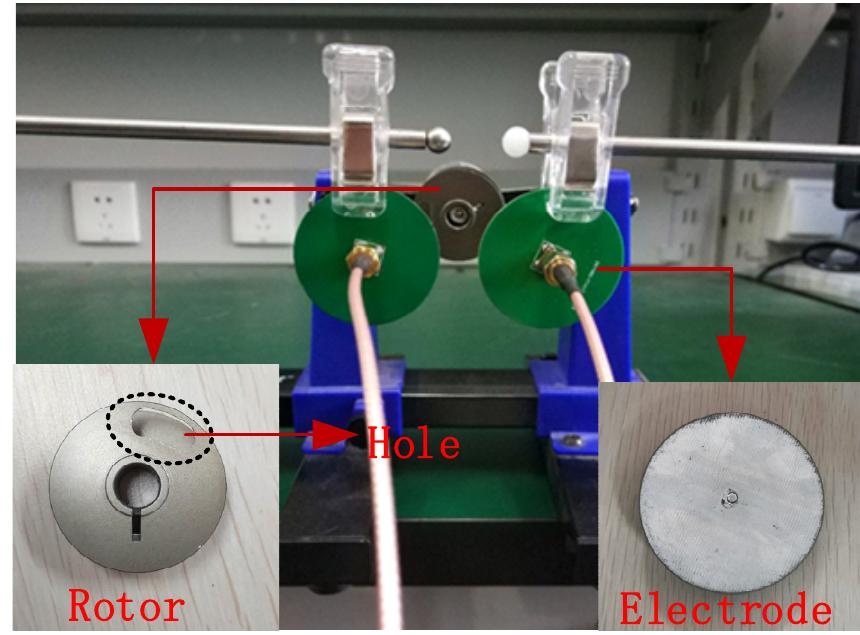
Figure 11. The experimental system for rotor motion .